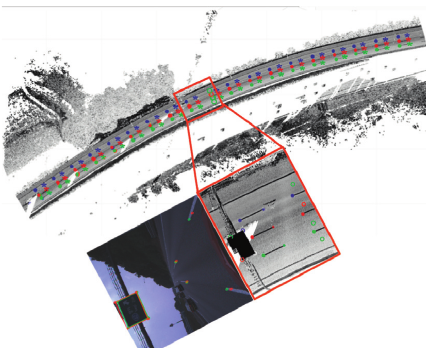
Figure 15: Example of camera hypotheses and ego-lane identifi- cation result in a curved road.